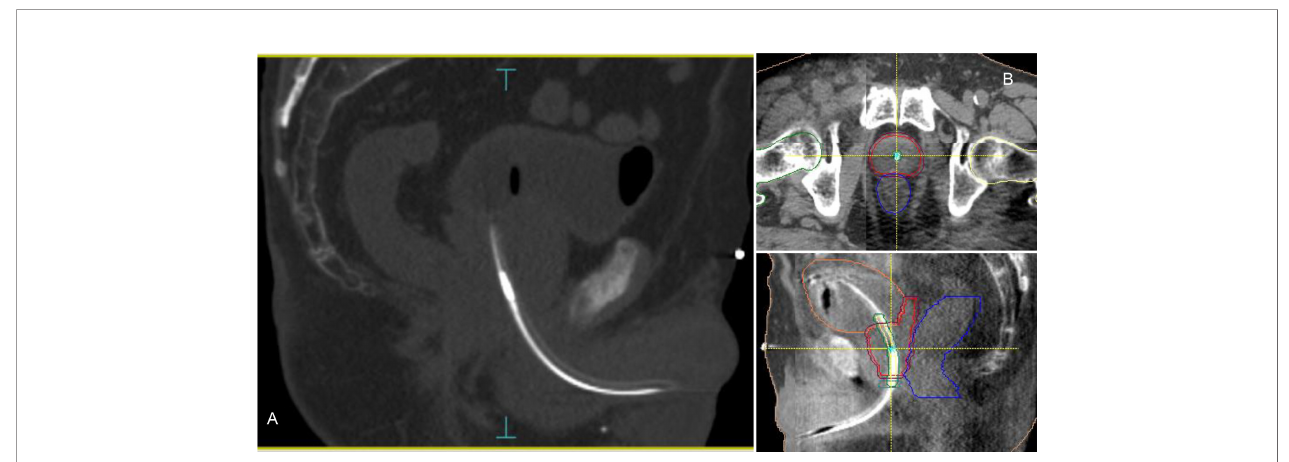
FIGURE 1 | RayPilot HypoCath. The transmitter choke is visible inside the urinary catheter within the prostatic urethra (A) . Planning CT to daily CBCT matching: proper rectum and bladder fi lling veri fi cation, in addition to transmitter and urethra localizations; in case of deformation or deviation of the urethral path, the catheter was placed inside the urethra PRV along with the entire extension of the prostate (B)